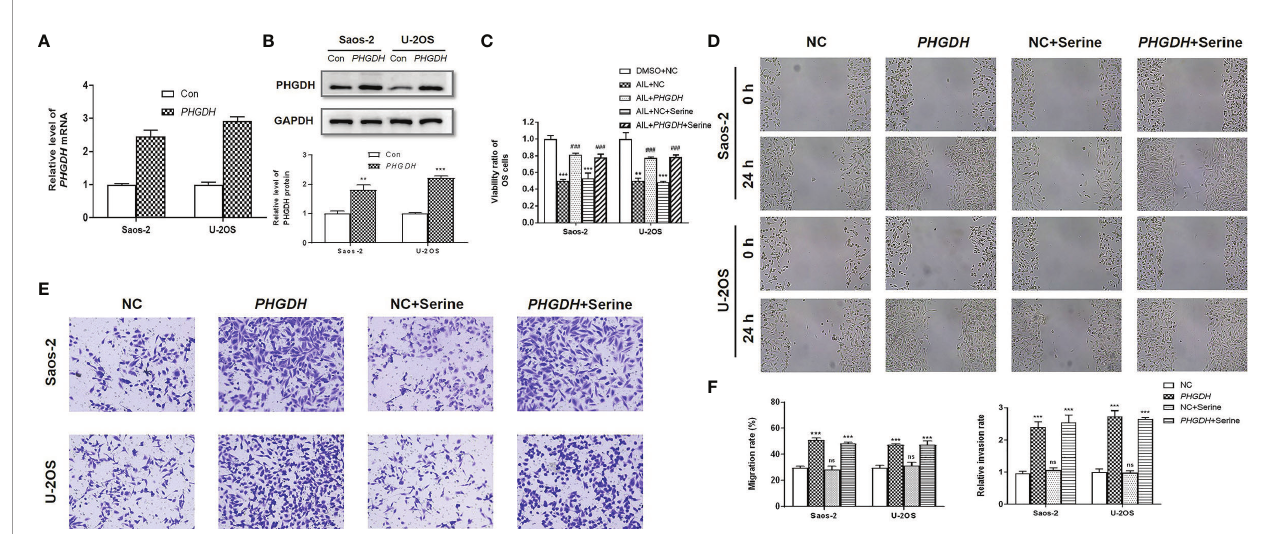
FIGURE 8 | Overexpression of PHGDH but not exogenous serine supplementation reversed the effects of AIL on OS cells. (A, B) Overexpression ef fi ciency of PHGDH was veri fi ed by qRT-PCR and Western blot assay. (C) OS cells were assigned to fi ve groups: negative control (NC) treated with DMSO (DMSO + NC), NC treated with AIL (AIL + NC), PHGDH overexpression treated with AIL (AIL + PHGDH ), NC treated with AIL and serine (AIL + NC + Serine), PHGDH overexpression treated with AIL and serine (AIL + PHGDH + Serine). The viability ratio of Saos-2 and U-2OS cells in the AIL + PHGDH group and AIL + PHGDH + Serine group but not in the AIL + NC + Serine group was signi fi cantly higher than that in the AIL + NC group (** P < 0.01, *** P < 0.001 compared with the DMSO + NC group, ### P < 0.001 compared with the AIL + NC group). (D) The wound healing assay revealed that overexpression of PHGDH but not exogenous serine supplementation reversed the suppressive effect of AIL on the migration of OS cells. (E) The Transwell assay demonstrated that overexpression of PHGDH but not exogenous serine supplementation reversed the suppressive effect of AIL on OS cell invasion. (F) Comparisons of the migration rates and relative invasion rates between the NC group and the other groups are shown (*** P < 0.001, ns P >